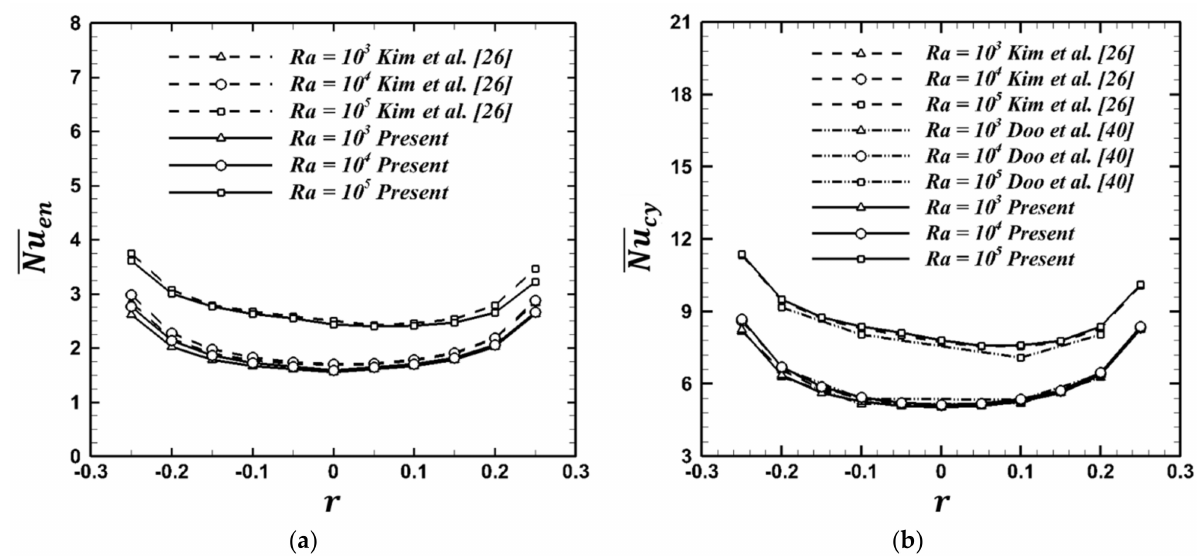
Figure 3. Comparison of present results of total surface-averaged Nusselt number with Kim et al. [26] and Doo et al. [40]: ( a ) the square enclosure, Nu en and ( b ) the inner circular cylinder, Nu cy .